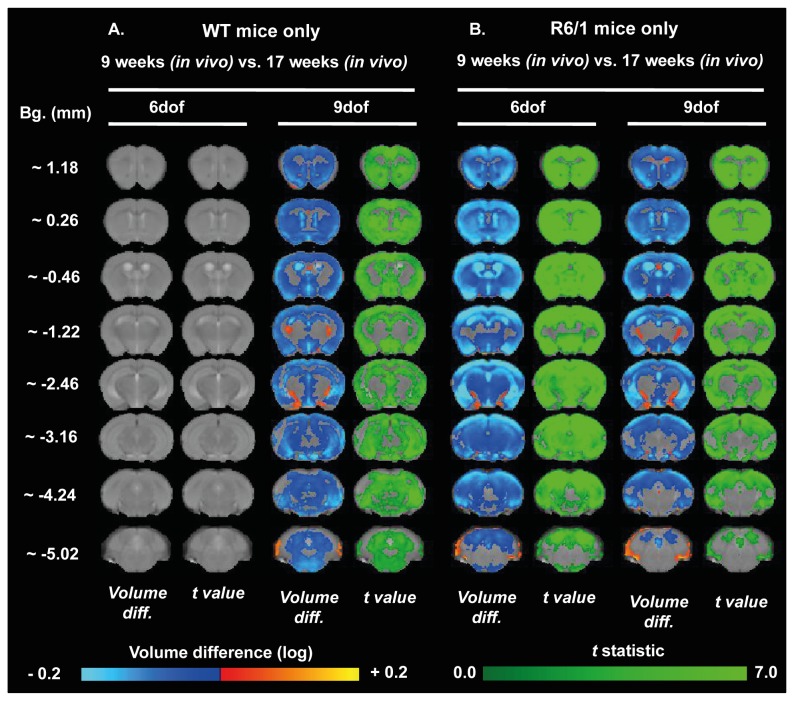
Age-related evolution of brain atrophy in male mice measured through TBM.Maps of local volumetric change in both male WT (A) and male R6/1 mice (B) between the two time points (9 and 17 weeks of age). Images presented as either global volume change (6 dof) or regional-specific changes corrected for global change (9 dof). Color scales are for volume difference (Volume diff., blue-to-yellow) and the raw t statistical value at each voxel (dark-to-light green). Only volume changes and effects-sizes which survive multiple comparisons corrections across all voxels in the brain (False Discovery Rate with q<0.05) are shown.